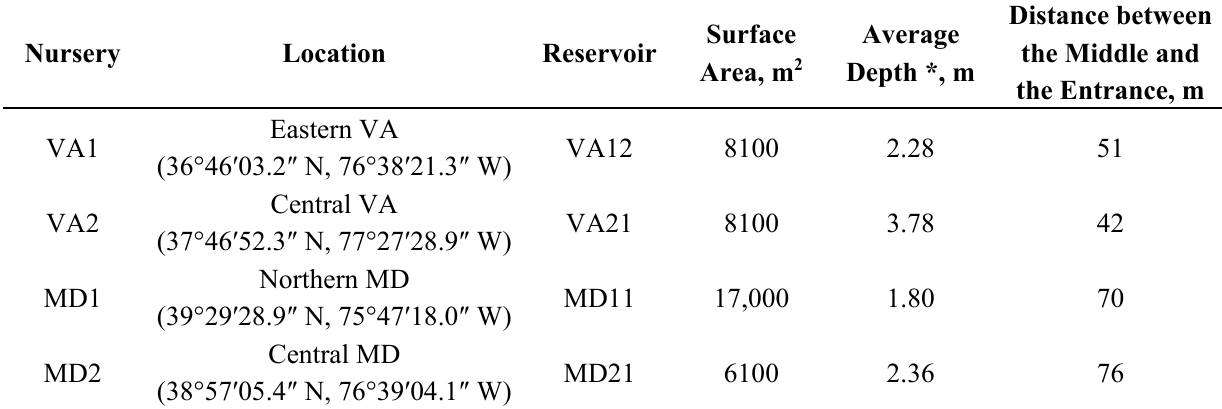
Table 1. Characteristics of recycling irrigation reservoirs